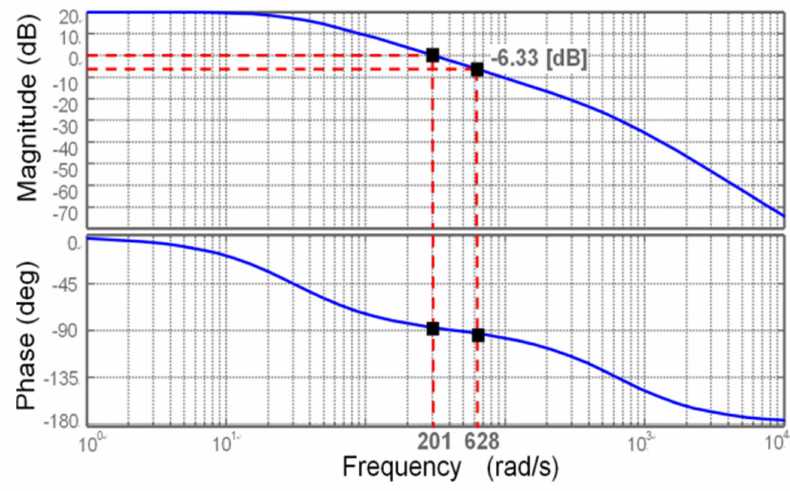
Figure 10. Bode plot for voltage